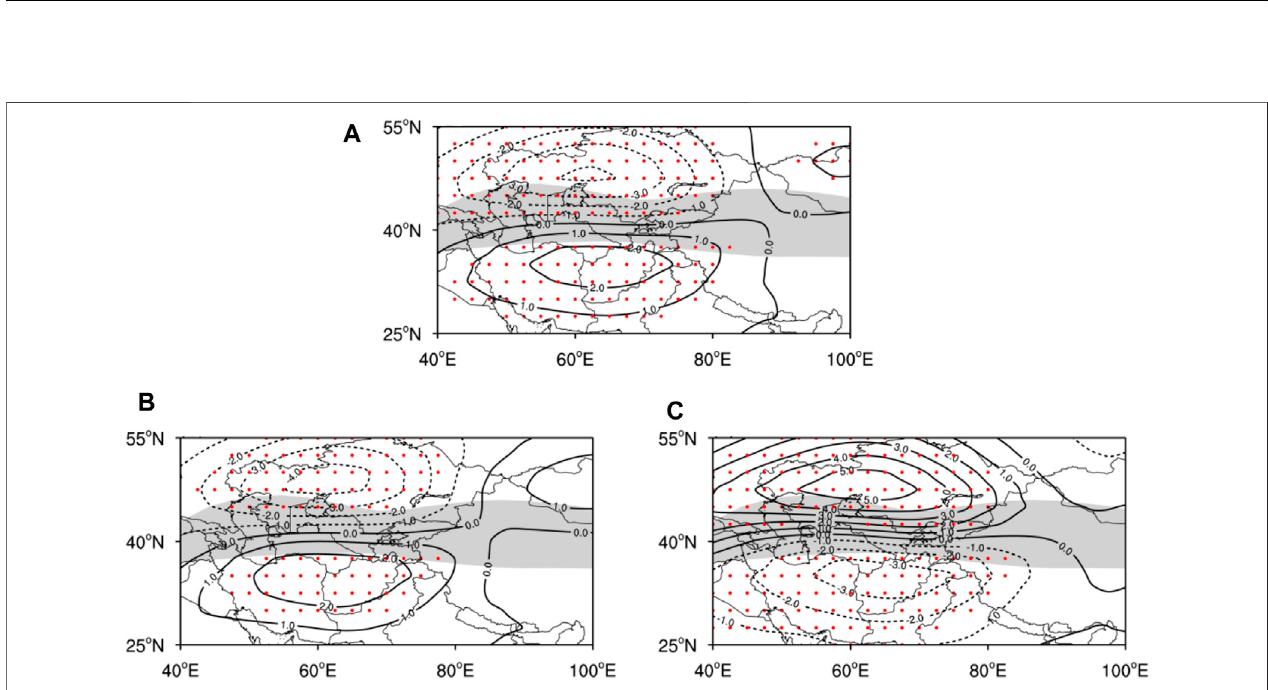
FIGURE4|(A) Regressionof200-hPazonalwindagainsttheCARIduring1971 – 2016, (B) compositedistributionof200-hPazonalwindanomaliesinstrongCARI years, (C) as (B) , but in weak CARI years. The shaded regions denote the climatological axis of the subtropical westerly jet (where wind speeds are larger than 25 ms − 1 , dotted regions show signi fi cance at α (cid:2) 0 . 05 level.